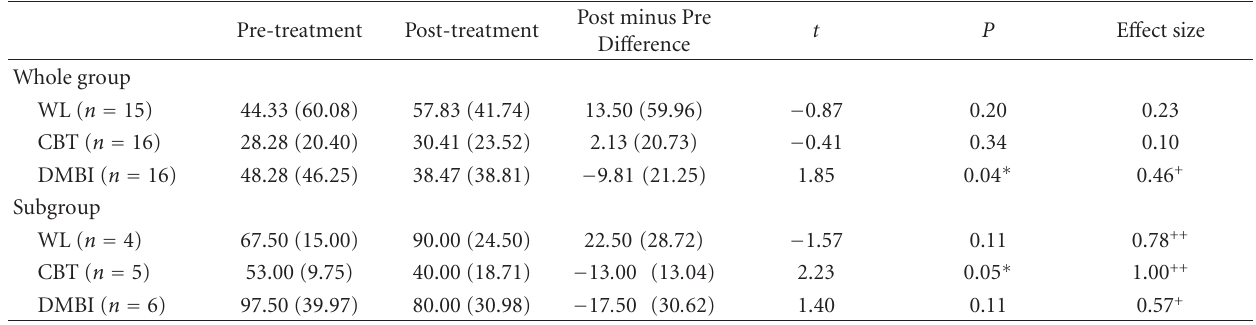
Table 4: Sleep onset latency (minutes) at pre- and post-treatment.